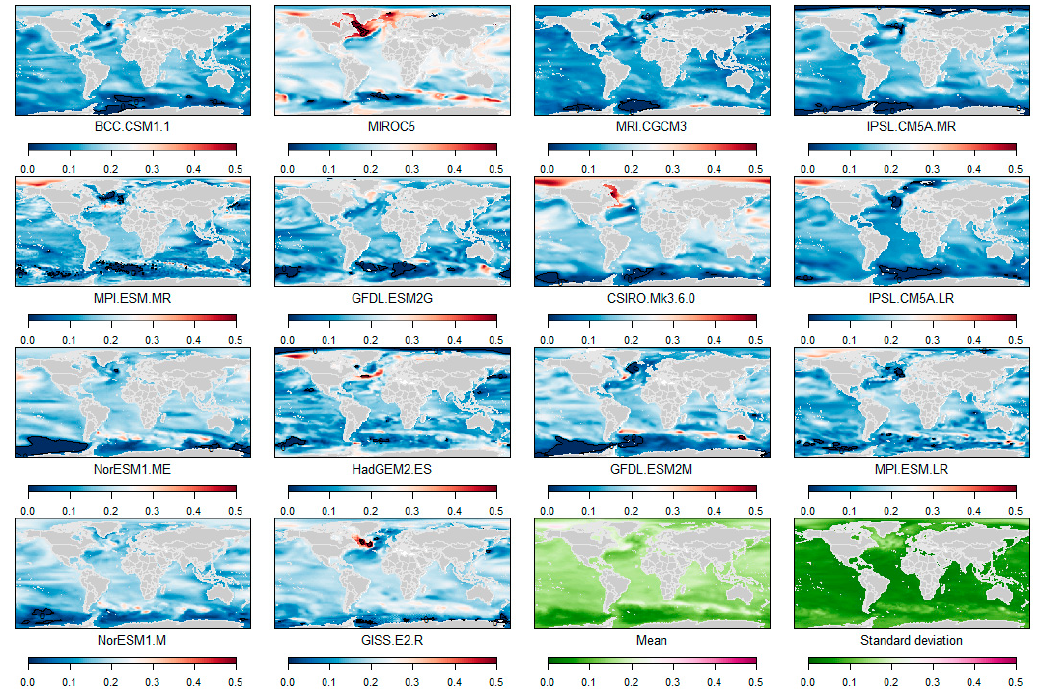
Figure A1. Sterodynamic sea-level changes (in m, for 2099 with respect to 1986–2005) for each climate model used in this study, their mean and standard deviation, for RCP2.6.